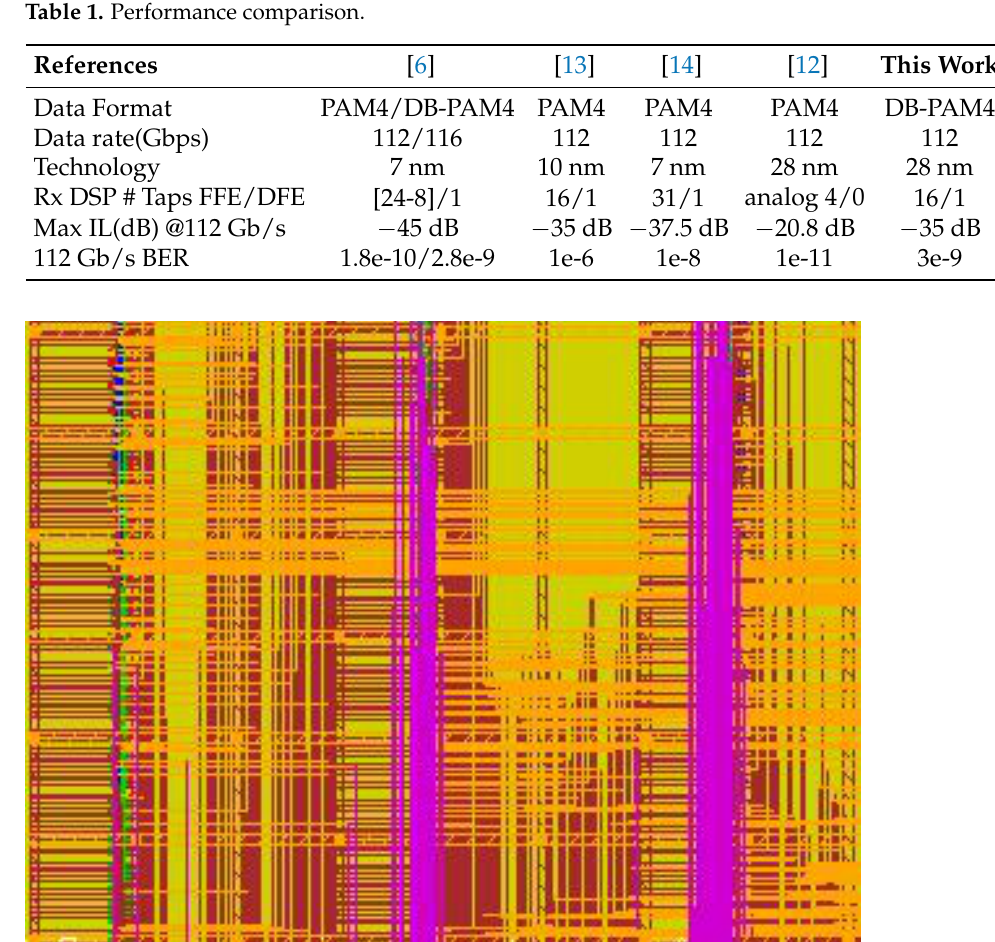
Figure 14. System layout of the DSP